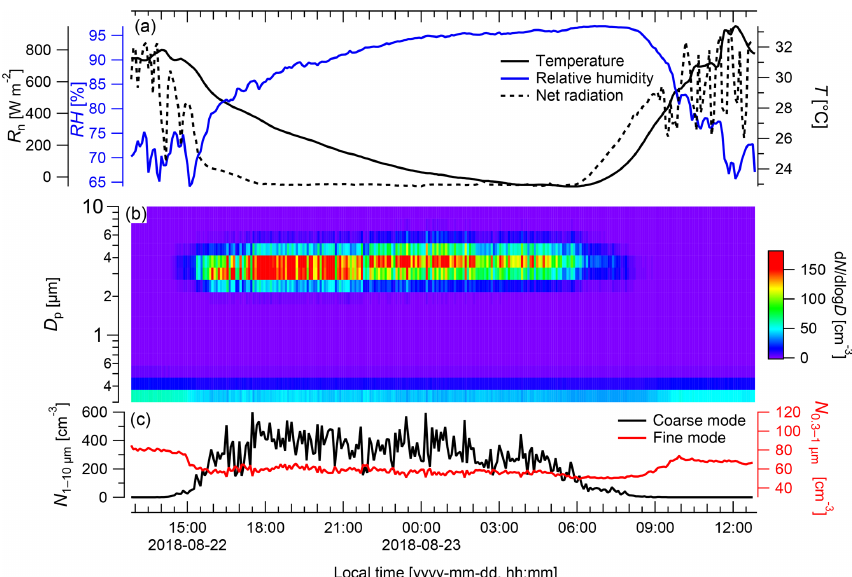
Figure 5. Particle emission patterns of Rigidoporus microporus measured under field conditions over the course of 24h. (a) Temperature ( T ) and relative humidity (RH) measured next to the sample organism and net radiation ( R n ) measured at a height of 75m, (b) concentration of different particle size classes over time, and (c) the number of particles ranging from 0.3 to 1µm (fine mode) and from 1 to 10µm diameter (coarse mode). Data are presented as 5min